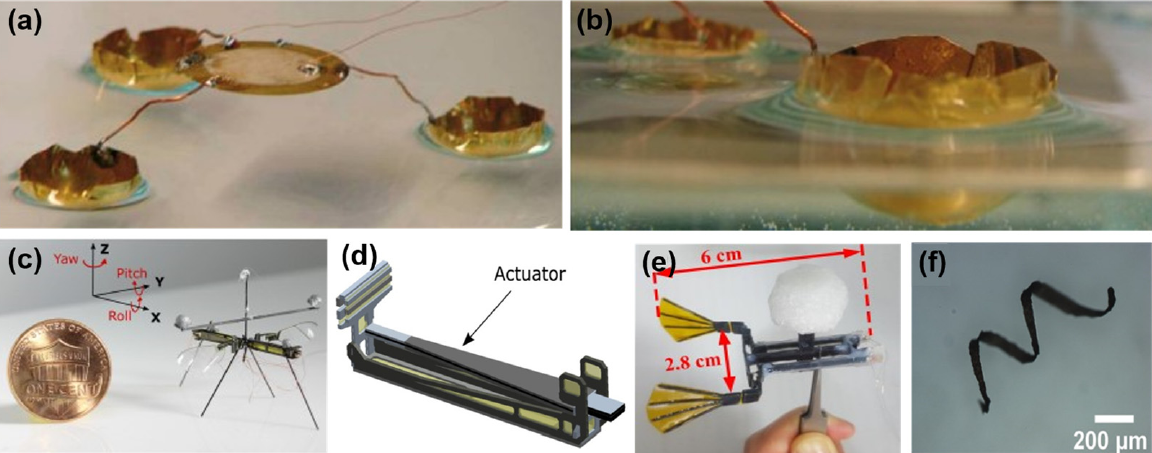
Figure 5. ( a ) Overall structure and ( b ) semi-submerged parts of the amphibious microrobot. Reprinted with permission from Ref. [18]. Copyright 2013, Springer. ( c ) Overall structure and ( d ) actuator of RoboFly. Reprinted with permission from Ref. [54]. Copyright 2021, IEEE. ( e ) Microrobotic fish. Reprinted with permission from Ref. [32]. Copyright 2021, Elsevier. ( f ) Piezoelectric micro Table 1. Summary of microrobots with different movement mechanisms. Length Scale Speed